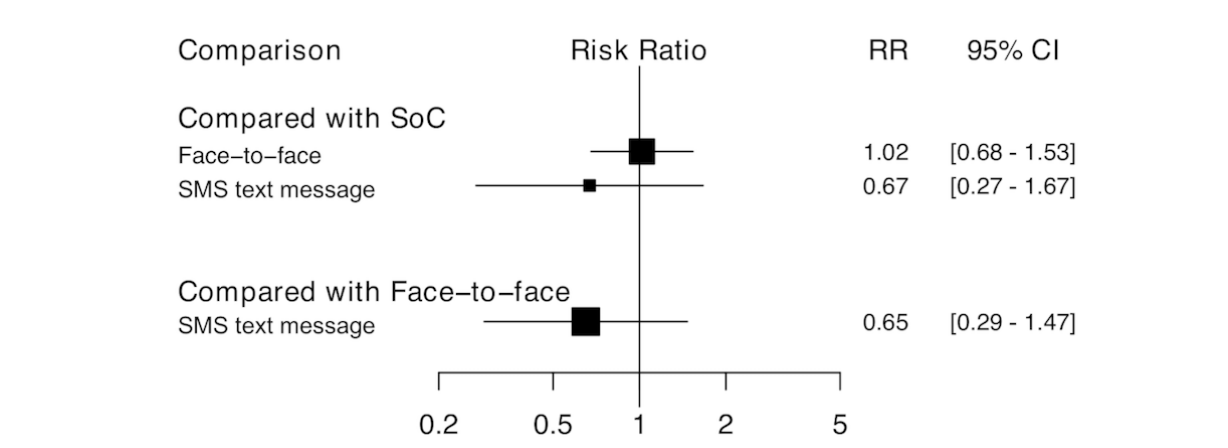
Figure 7. Pairwise comparisons of all interventions, long-term effect. RR: risk ratio; SMS: short message service; SoC: standard of care, no intervention control.